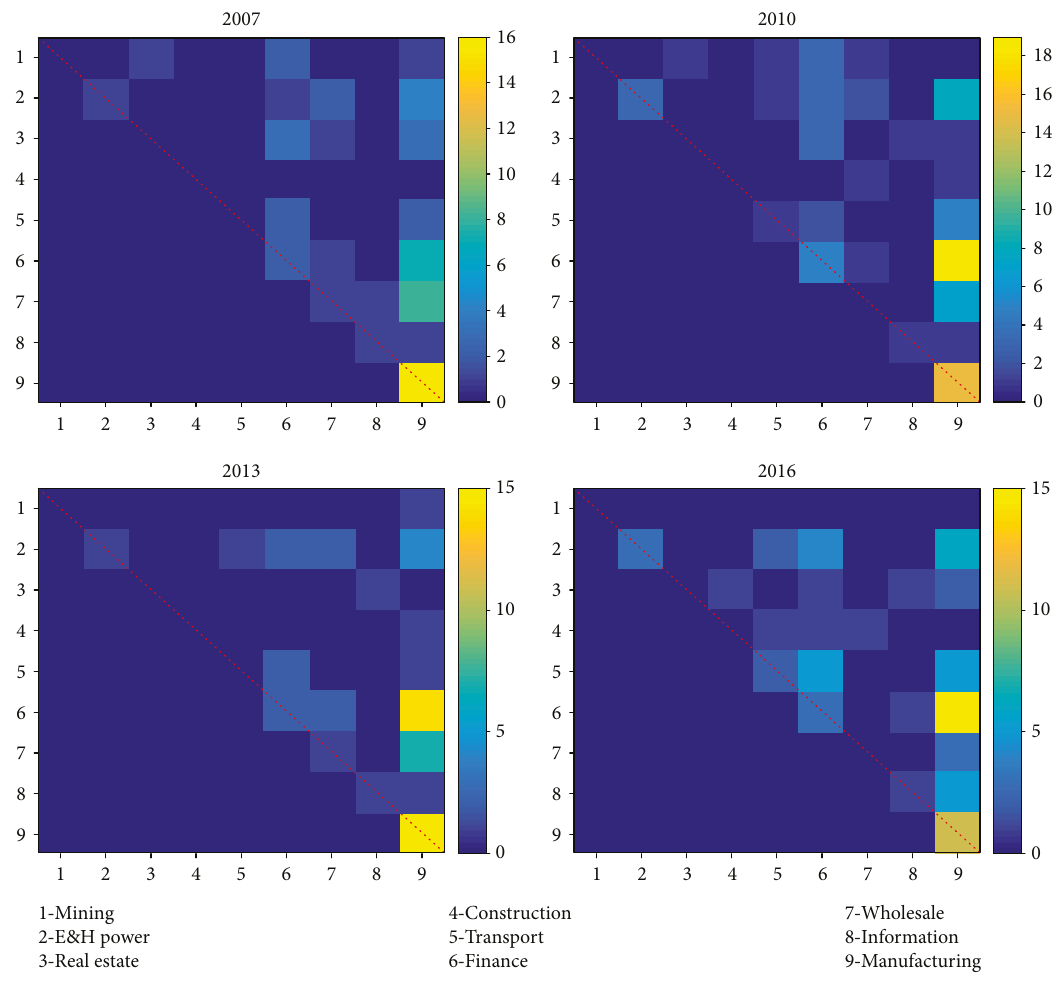
Figure 5: The number of coshareholder relationships among industries in motif